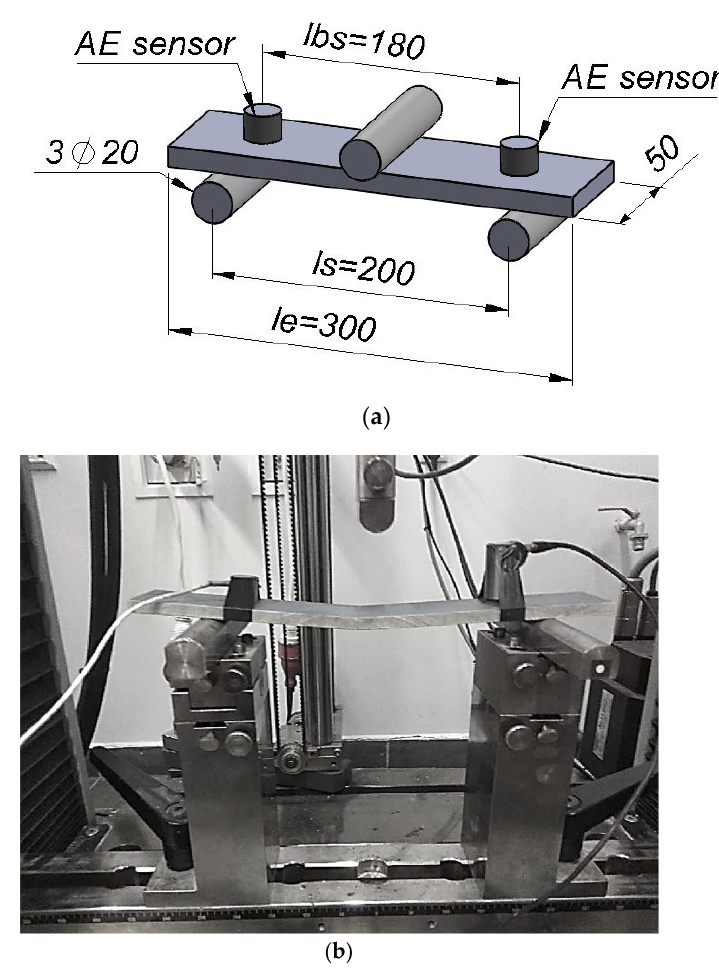
Figure 1. Test stand: ( a ) scheme; ( b ) photograph.